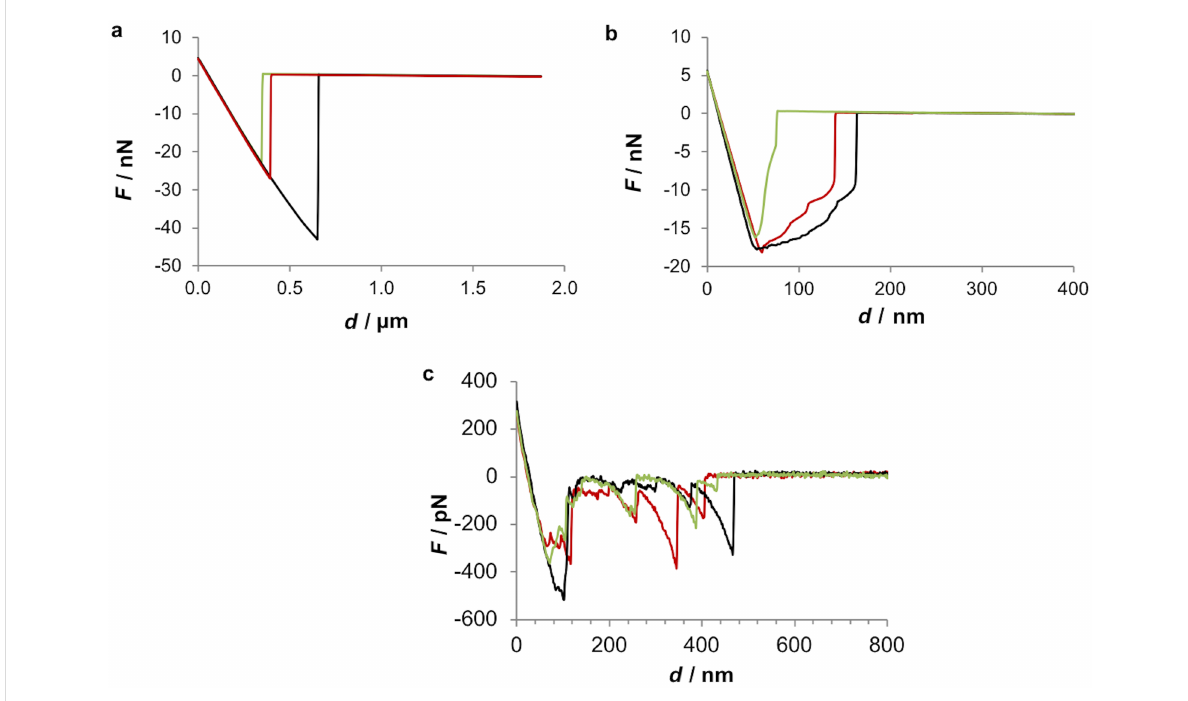
Figure 6: Force–distance retracting curves of the adhesive material deposited by the tube feet of Paracentrotus lividus on mica. The adhesive materi- al was observed either dry (a), moist (b) or under native (c) conditions. The data was obtained either with a ScanAsyst-Air probe (a, b) or a silicon nitride probe (SNL, Bruker) (c). Different coloured lines represent three independent trials.